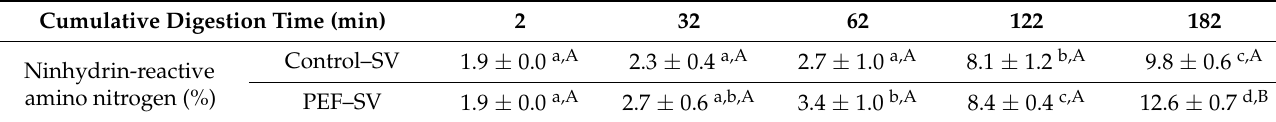
Table 2. Ninhydrin-reactive amino nitrogen released from the control sous vide (SV)-cooked and the pulsed electric field (PEF)-treated SV-cooked meat after in vitro oral–gastric (2, 32 and 62 min) and further small intestinal (122 and 182 min)